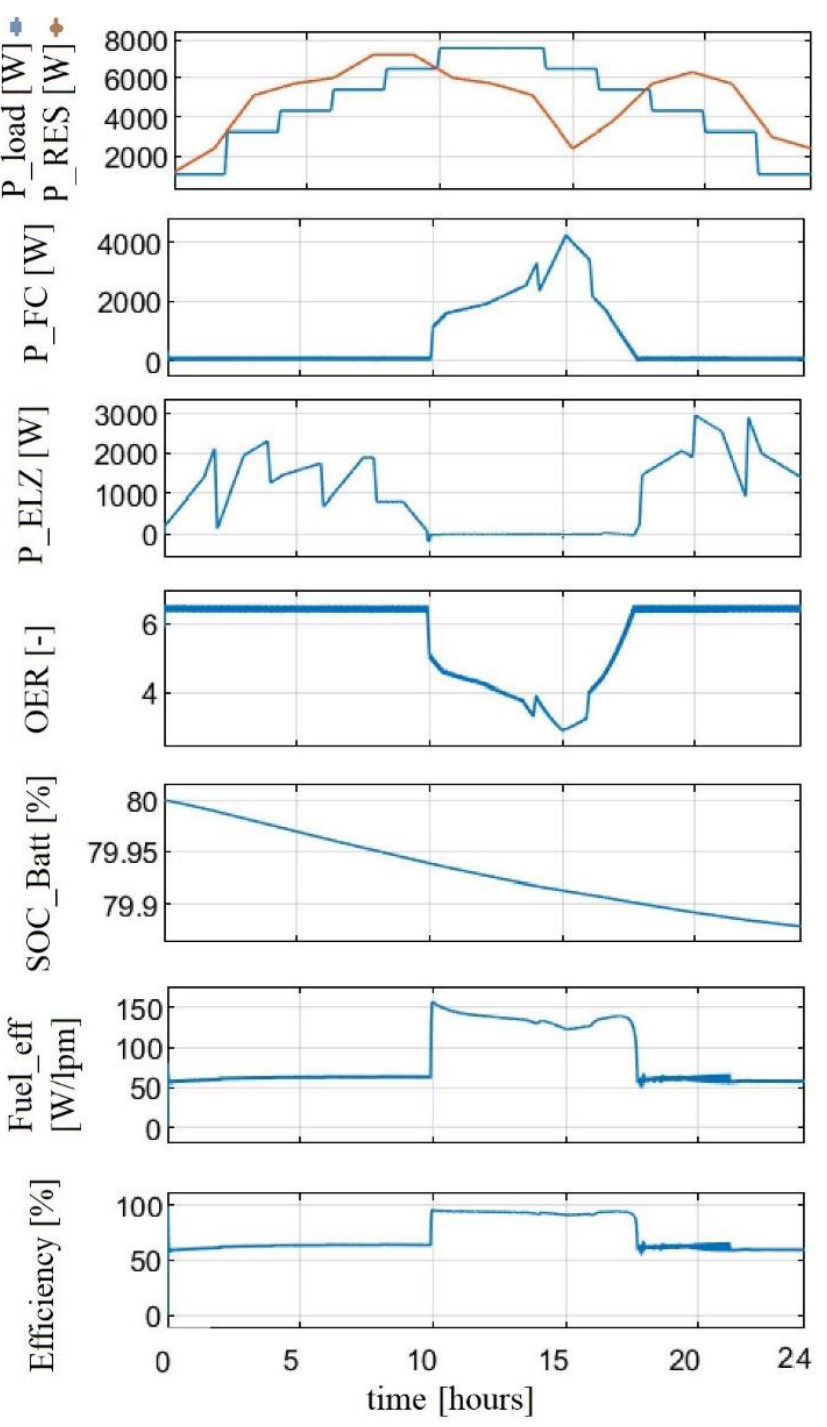
Figure 6. Operation of the charging station based on the FC/ELZ/RES DCmG when 𝑝 𝑅𝐸𝑆 and 𝑝 𝐿𝑜𝑎𝑑 are comparable.